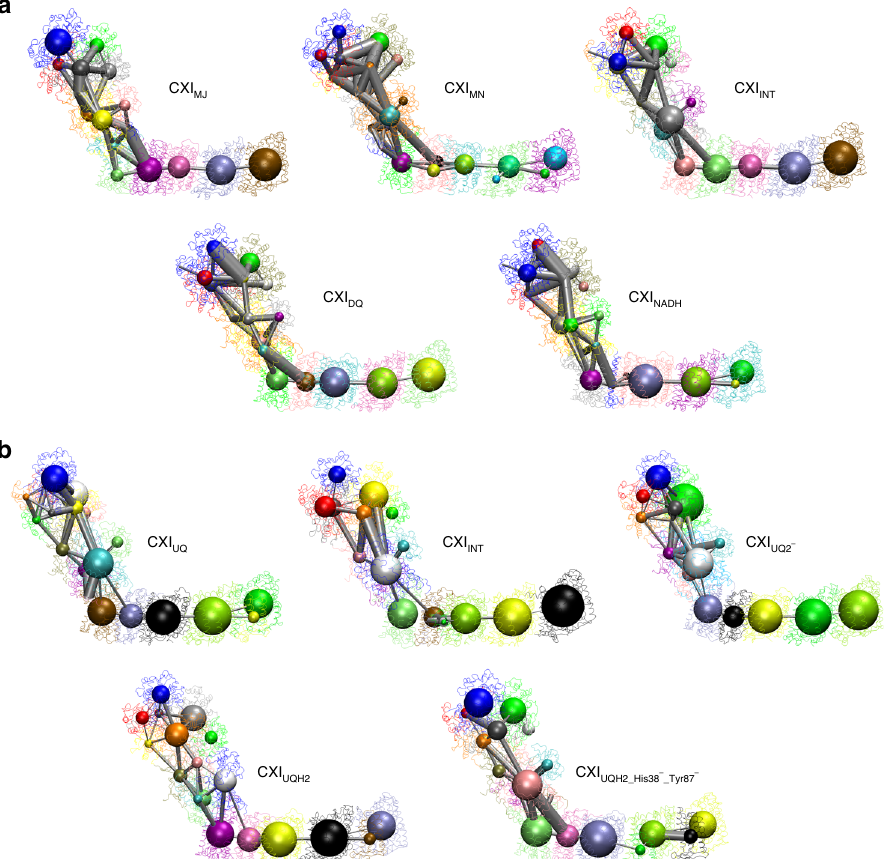
Fig. 8 Network analysis of potential allosteric couplings between respective regions of complex I. a Analysis of experimentally determined structures, as indicated. b Analysis of the results of CG-MD simulations. Detected substructures or communities (nodes) of highly intra-connected (coupled) residues are shown as spheres, with sphere radius proportional to the number of residues included in the node. Colours of spheres correspond to particular communities, which vary between the systems. The grey lines or edges demonstrate sparse and functionally relevant connections (allosteric pathways of signal propagation) between these communities. The strength of coupling is proportional to the edge thickness. The NMA calculations were performed with the HCA force- fi led and network analysis was performed with the correlation cut-off of 0.45 a or 0.50 b